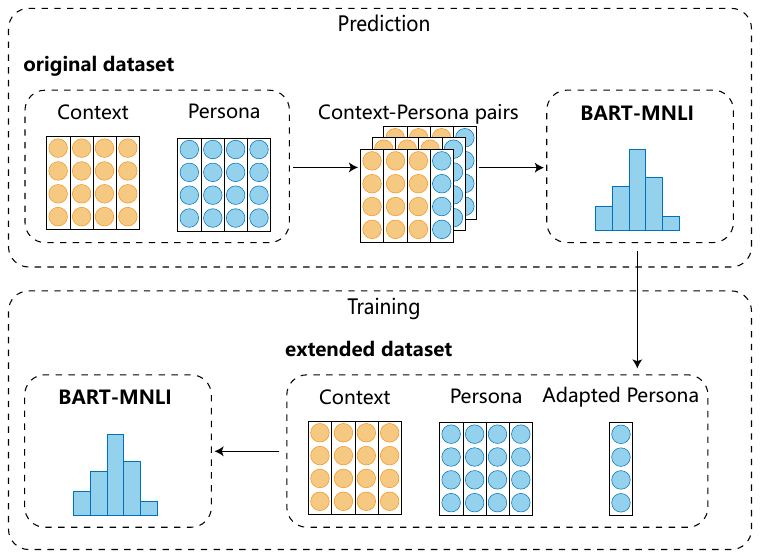
Figure 4. The traning and prediction processes of classifier C ps . The prediction process is applied twice, firstly to construct the expanded dataset, where the response replaces the context. The second is to give the adapted persona when training our model. The training process uses the expanded dataset to fine-tune the classifier and improve the accuracy of the persona